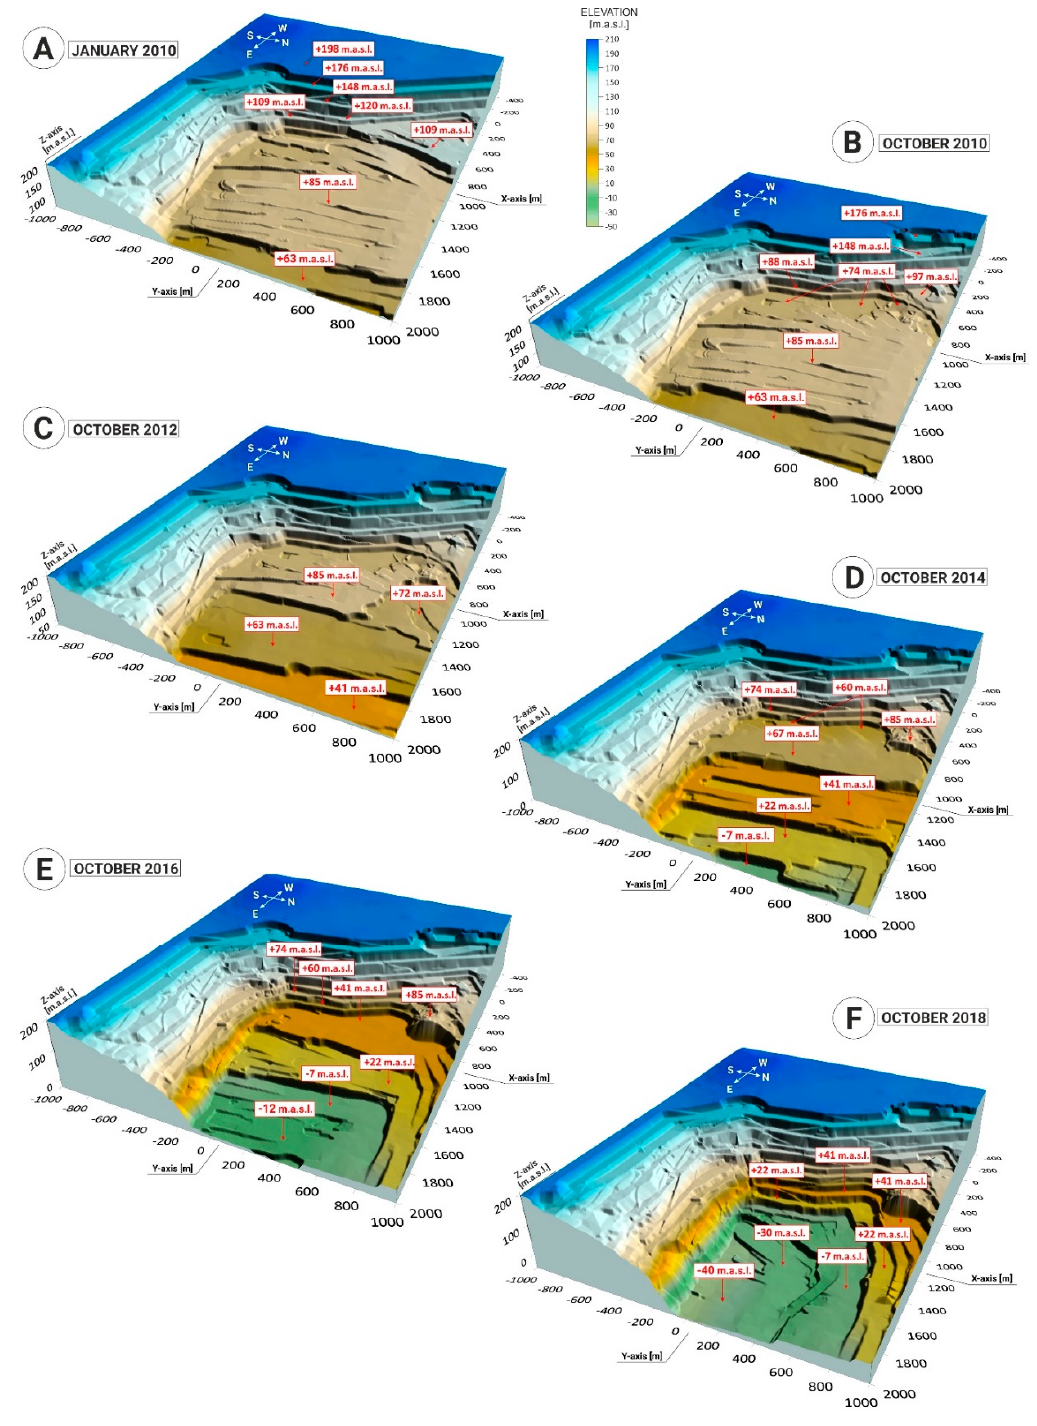
Figure6. Ligniteextractionprogressintwo-yearsperiods: ( A )—January2010(initialstate), ( B )—October Figure 6. Lignite extraction progress in two-years periods: A —January 2010 (initial state), 2010, ( C )—October 2012, ( D )—October 2014, ( E )—October 2016, and ( F )—October B —October 2010, C —October 2012, D —October 2014, E —October 2016, and F —October 2018.